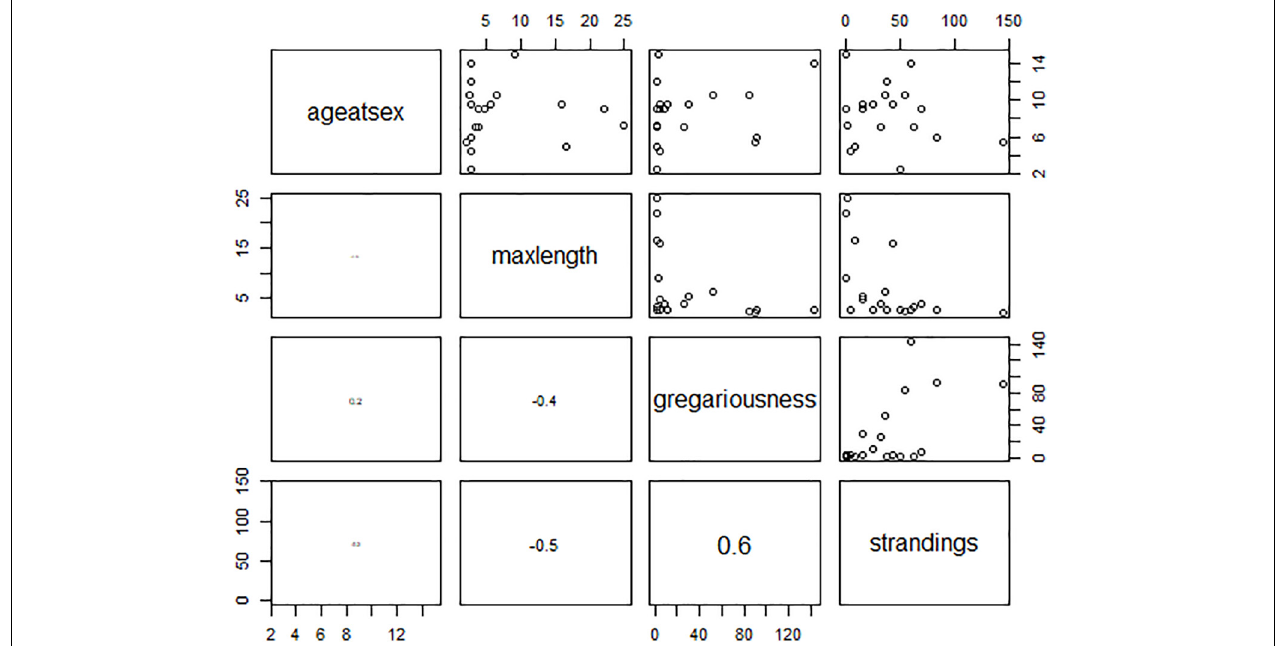
FIGURE 4 | Correlation matrix of the explanatory variables using pairplots. The lower panels show the Pearson pairwise correlation with font size proportional to correlation coefficient. Variance inflation factors of the covariates are all below the threshold of 3. Diagonal text panels are ageatsex = age at sexual maturity; maxlength = maximum length; gregariousness = group sizes; strandings = frequency of strandings.